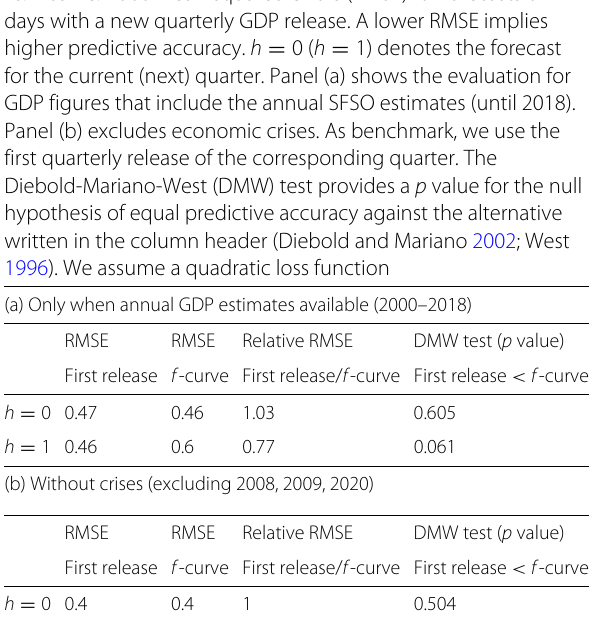
RMSE Relative RMSE DMW test ( p value) First release f -curve First release/ f -curve First release < f -curve h = 0